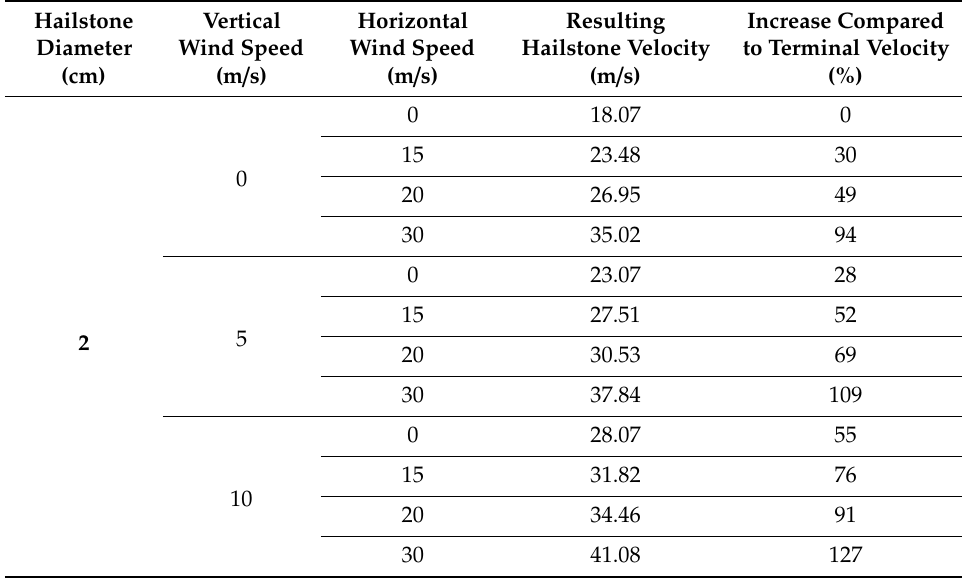
Table 1. E ff ect of vertical and horizontal wind speed on the resulting velocity compared to the terminal velocity of di ff erent sized